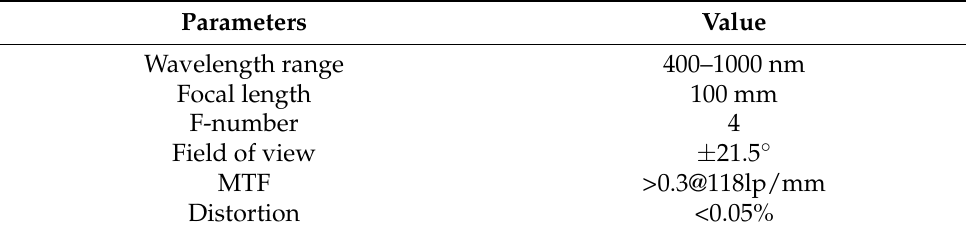
Table 2. Technical Specifications of the optical